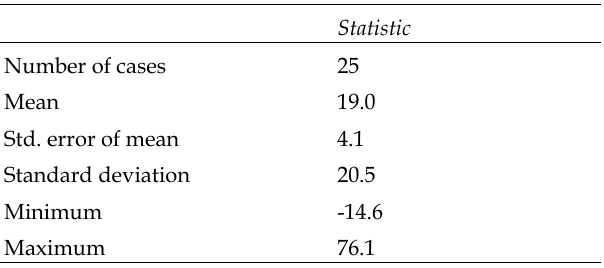
Table 4. Summary statistics for the forecast inaccuracies for toll free